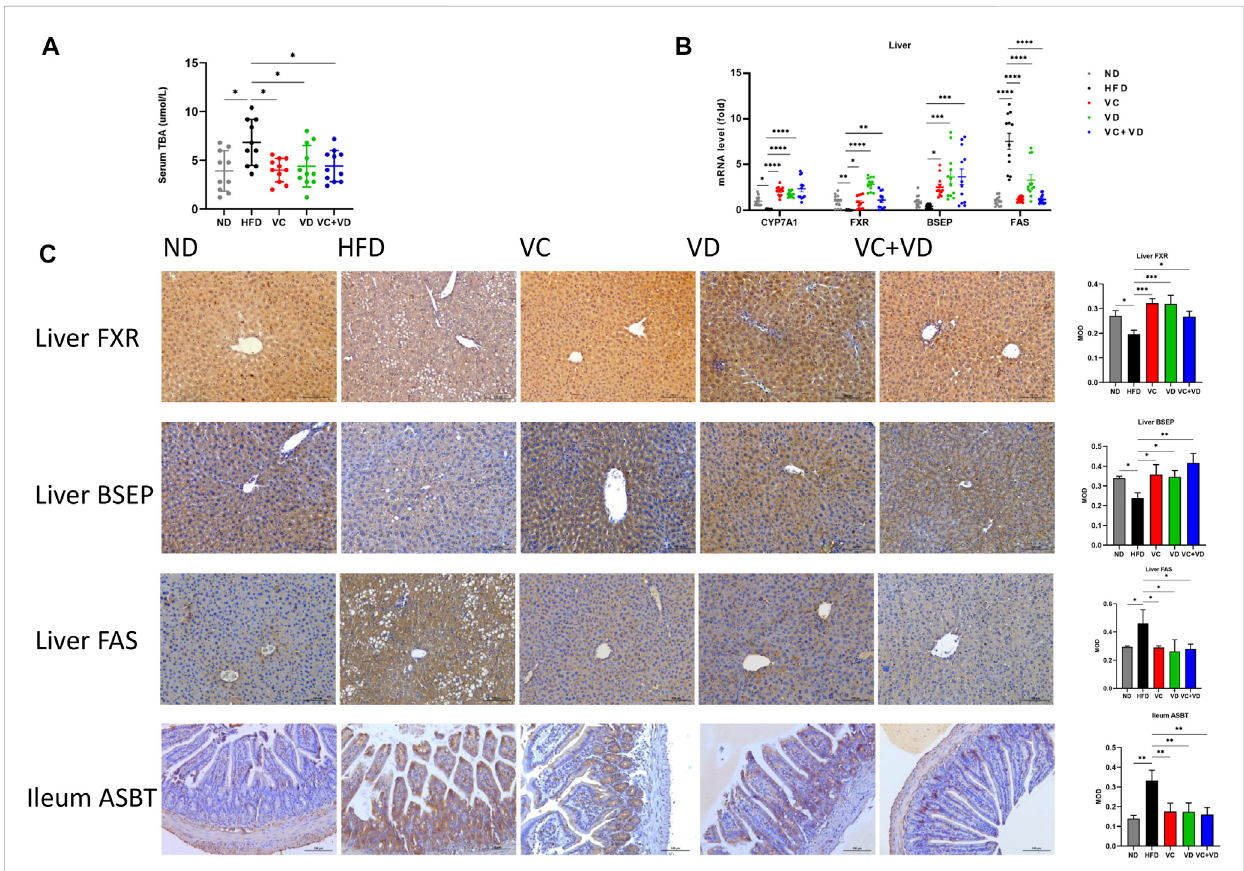
FIGURE 8 VC and VD 3 attenuated bile acid metabolism dysfunction in the gut-liver axis in obese mice. (A) Serum levels of total bile acid. (B) Expression of mRNAs involved in the regulation of the synthesis and transport of bile acids and fatty acid synthase (FAS) in the liver. (C) Immunohistochemistry analysis of FXR, BSEP, and FAS in the liver and ASBT in the ileum of mice. The brown dot indicates the target protein. Representative images were captured. Scale bar, 100 µm. Data are shown as the means ± SDs ( n = 12 mice/group), * p < 0.05, ** p < 0.01, *** p < 0.001, **** p <